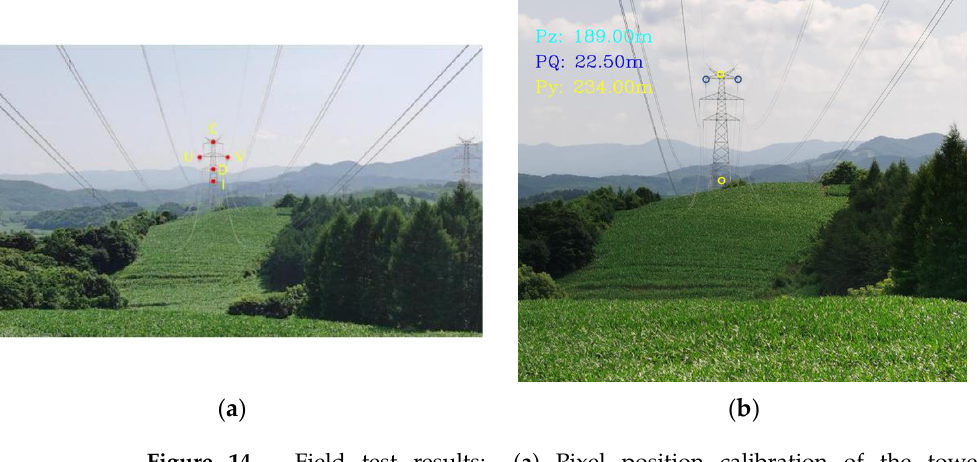
Figure 14. Field test results: ( a ) Pixel position calibration of the tower components; ( b ) Calibration